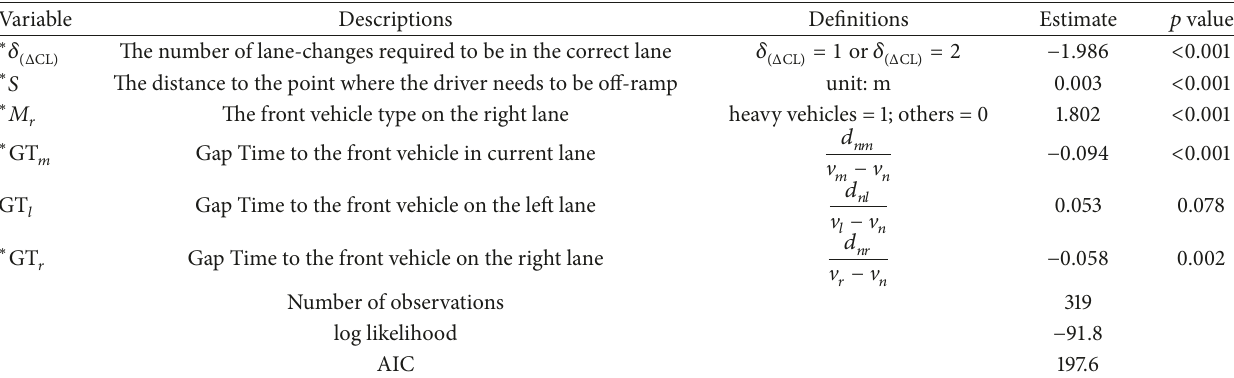
Table 2: Model estimation